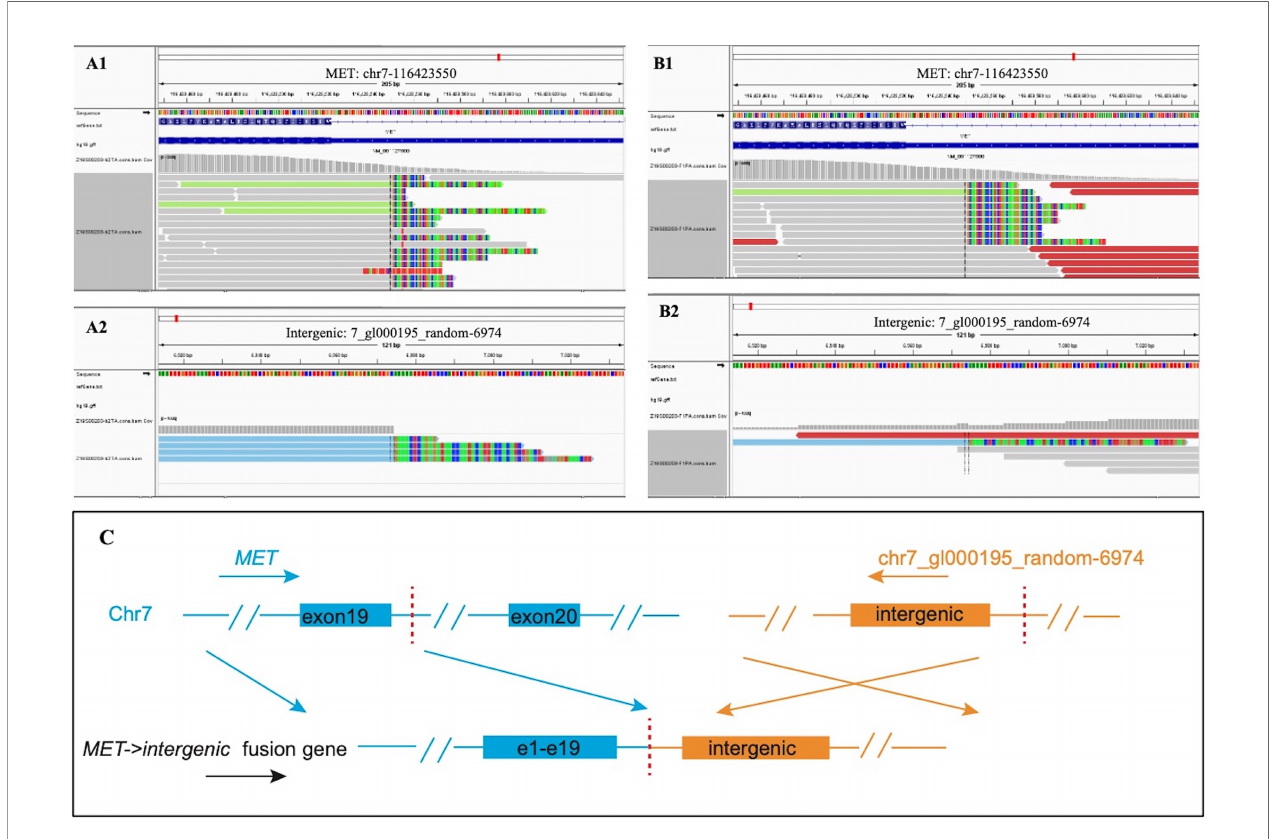
FIGURE 2 | Next-generation sequencing revealed MET intergenic fusion. Mapping of fusion junction sequence revealed the fusion of random sequences to MET gene. The breakpoints were located on chr7_gl000195_random: 6974 and chr7:116423550 in intron 19 of the MET gene, and the sequence of MET is reversed. (A) DNA sequencing reads indicating fusion region by genomics Viewer software in tissue. (B) DNA sequencing reads indicating fusion region by genomics Viewer software in plasma. (C) The breakpoints detected in the fusion by targeted next-generation sequencing (NGS) and the alterations in gene caused by this